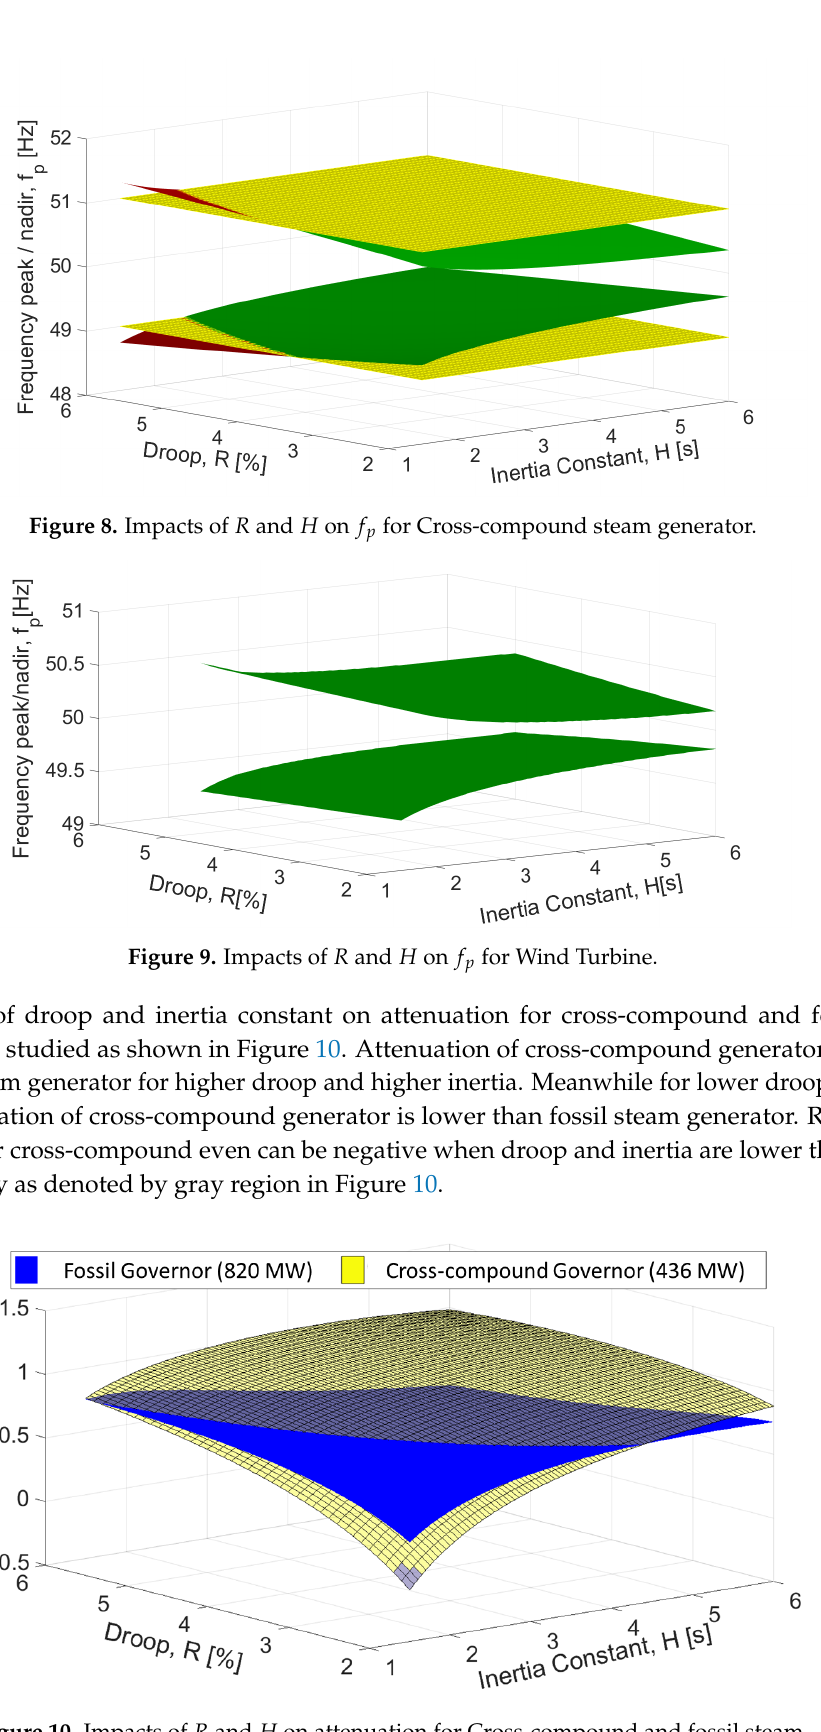
Figure 10. Impacts of R and H on attenuation for Cross-compound and fossil